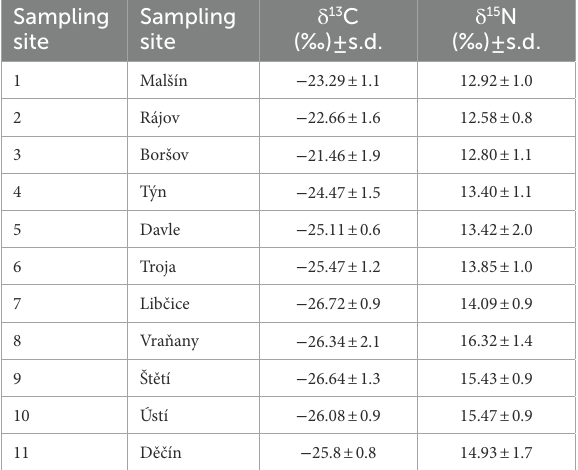
TABLE 2 Mean stable istotope ratios (± standard deviation) at sampling sites. Sampling